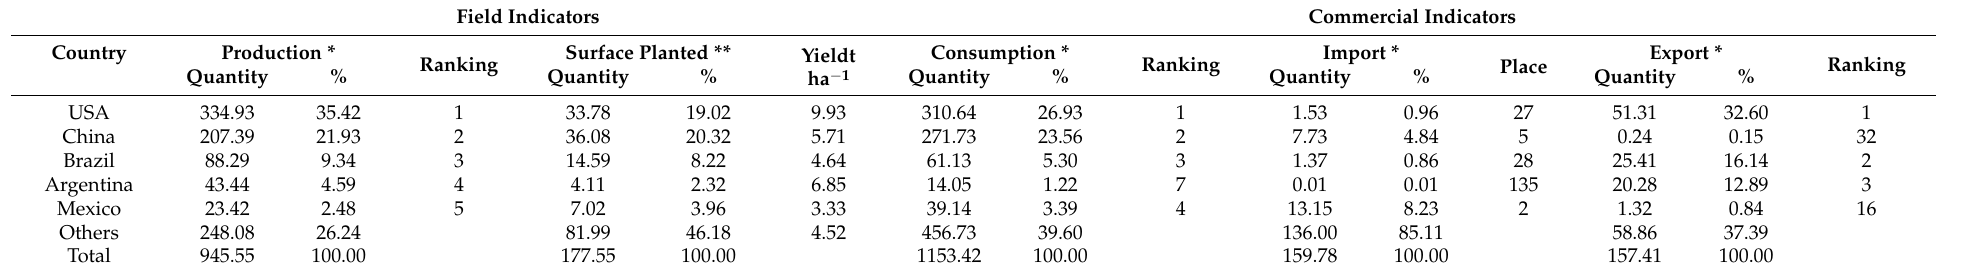
Table 2. Field and commercial indicators of the main producer and consumer countries of grain maize at the global level from 2007 to 2018. Field Indicators Commercial